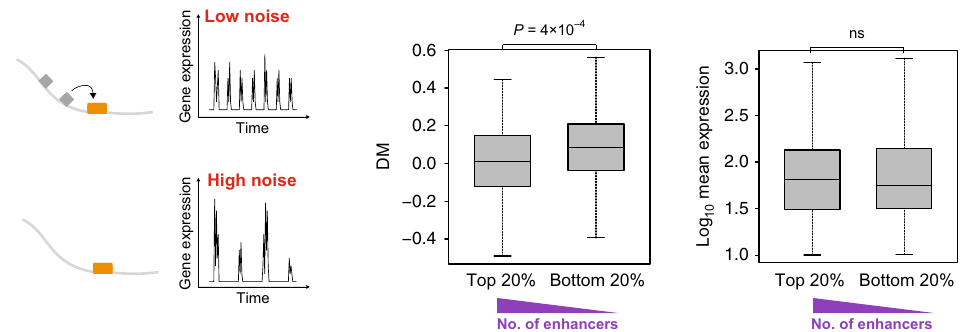
Fig. 5 Effects of 2D and 3D neighborhood on transcriptional kinetics. a Histogram of simulated median distances under a null model assuming no positional preference in the neighborhood of PRCr genes. The observed median distance of PRCa genes to their nearest neighbor in the PRCr group, depicted by vertical dashed red line, are signi fi cantly less than expected by chance (empirical P = 2 × 10 − 2 ). b Analyzing mESC Promoter Capture Hi-C data reveals that PRCa genes have a strong enrichment for long-range contacts between promoters with levels in between PRCr and active genes. Error bars represent s.e.m. c PRCa genes have signi fi cantly more interactions with active enhancers compared to PRCr genes ( P < 2.2 × 10 − 16 ). In contrast, interactions with poised enhancers are mainly observed for PRCr genes rather than PRCa ( P < 2.2 × 10 − 16 ). d Occurrence of interactions with active enhancers decrease noise of PRCa genes independent of the mean expression